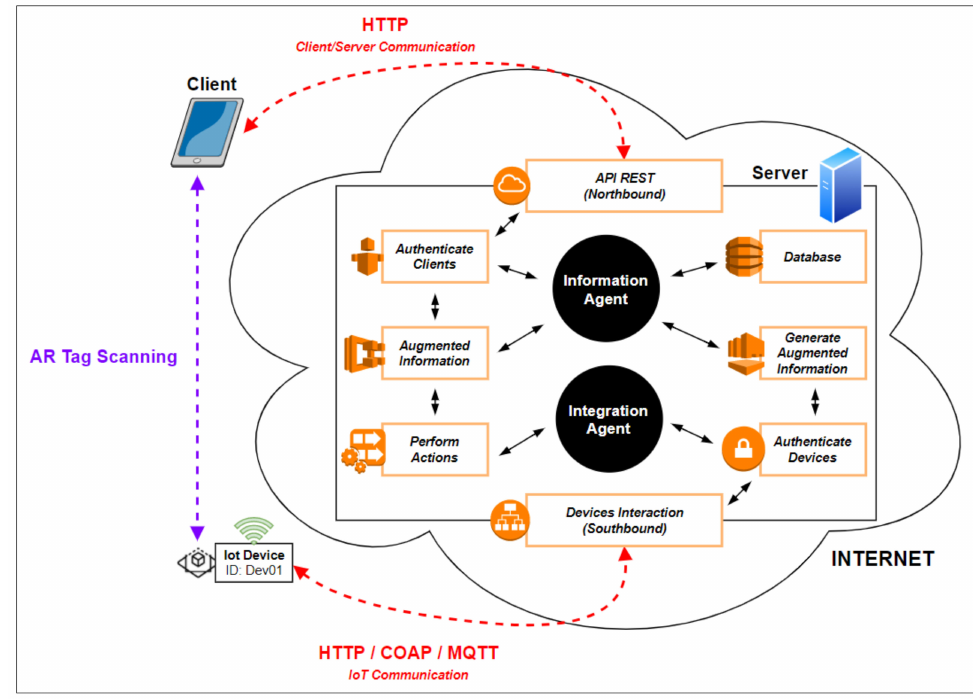
Figure 5. Visualization module and integration module architecture.